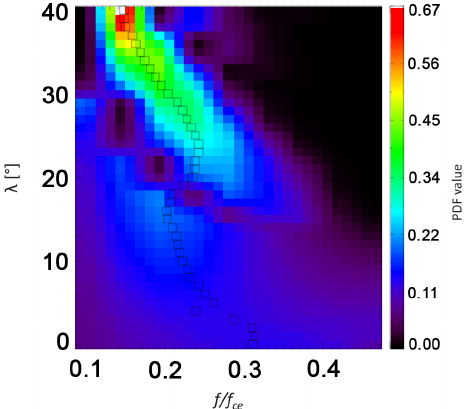
Figure 2. Power spectrum of chorus waves as a function of latitude obtained from our simulations for MLT = 09:00, 4 < L < 6 and K p = 4. The peak frequency (data is fitted by a Gaussian function) for each 1 ◦ latitude range is indicated by a black square. Colourbar indicates the normalized PDF